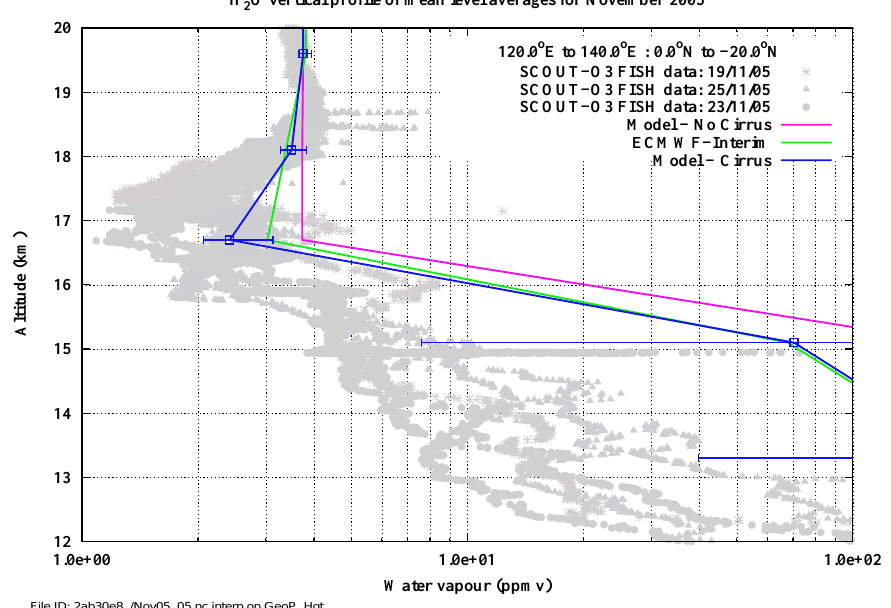
Fig. 5. Comparison of vertical profiles of water vapour from the integrated model and measurement data. The grey background points are data gathered by the aircraft-borne FISH instrument during the SCOUT-O3 campaign over Darwin in 2005. The measured data are point samples whereas the model data are the monthly mean of model cells from the region at each height layer. The horizontal bars on the model data show the range of values found on each layer in the region. The magenta trace shows the water vapour values from the model with advection from within the meteorological analysis region, but without the cirrus parameterisation. The ECMWF-Interim trace shows the amounts of water vapour diagnosed in the meteorological